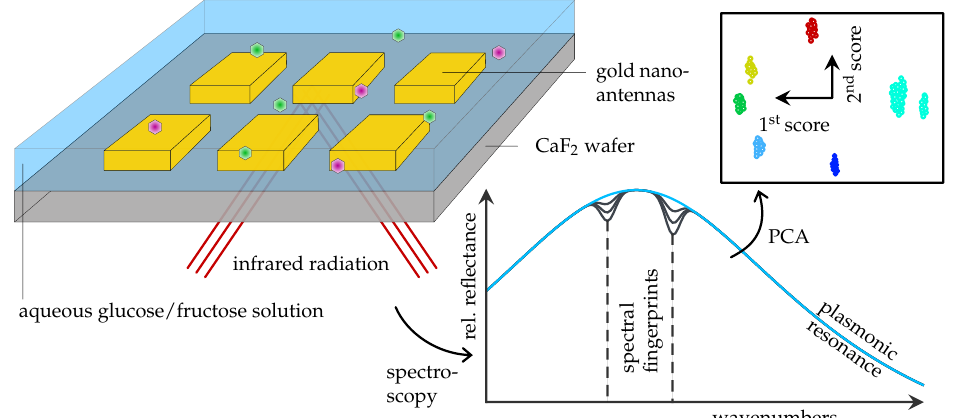
Figure 1. Schematic overview of the SEIRA spectroscopy glucose sensing setup by Kühner et al. [23]: on top, the irradiated reflective flow cell with gold nanoantennas containing an aqueous monosac- charide solution; below, an abstracted plot of the measured spectrum and its principal component